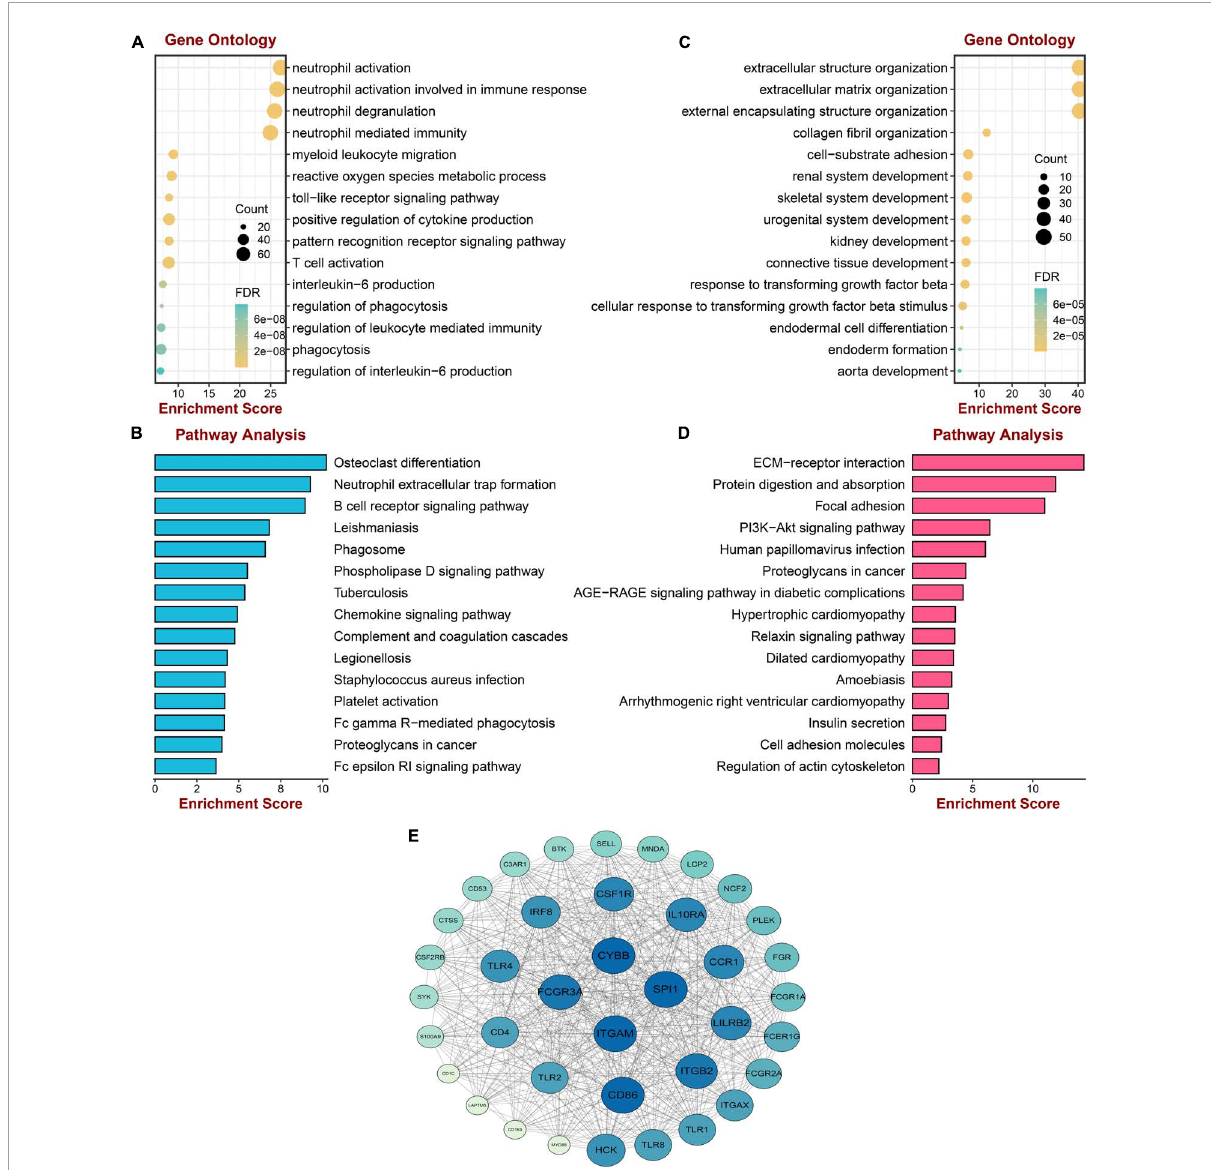
FIGURE3 Enrichment analysis and protein–protein interaction construction of key modules. (A) GO enrichment analysis of genes in the red module. (B) KEGG pathway analysis of genes in the red module. (C) GO enrichment analysis of genes in the salmon module. (D) KEGG pathway analysis of genes in the salmon module. (E) The protein–protein network of two